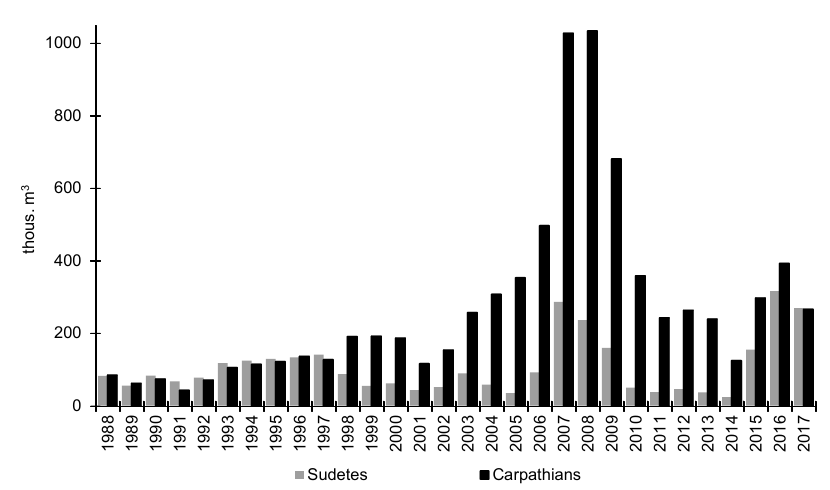
Figure 2. Volume of harvested spruce logs affected by bark beetles from trees in the Carpathian and Sudetes mountains between 1988 and 2017.